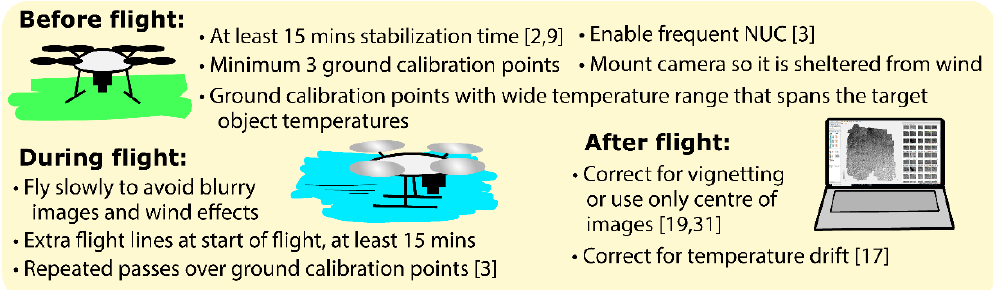
Figure 10. Recommendations for deriving robust data from an uncalibrated UAV TIR camera based on the results of this study and the literature.